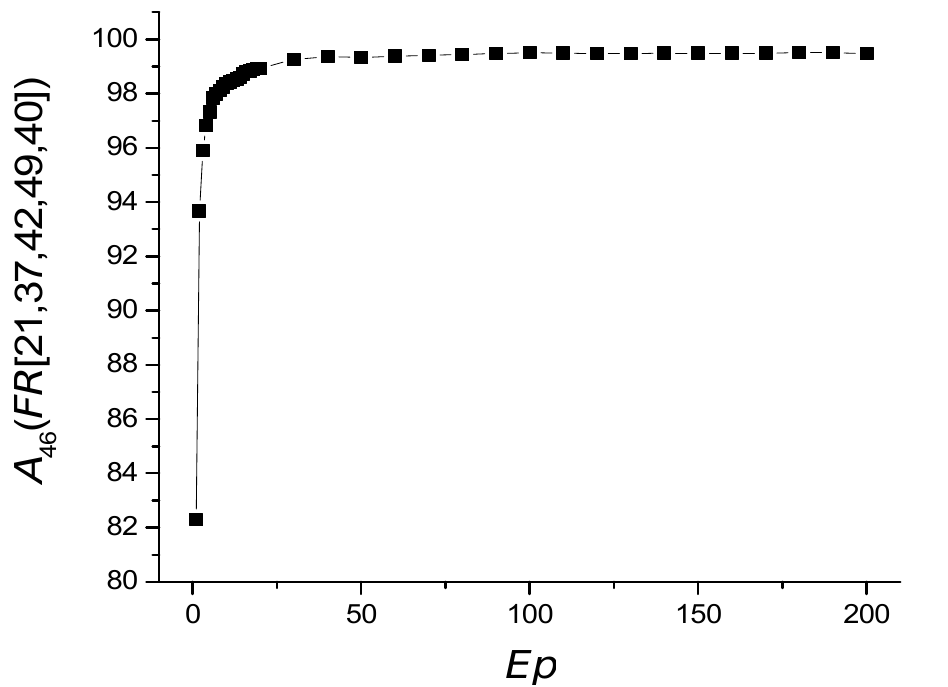
Figure 4. Function of the feature strength dA 51 ( z ) ( a ), dA 46 ( z ) ( b ). The dependence of A ( FR [21,37,40,42,49]) on the number of epochs is shown in 46 Figure 5, and the values of other metrics are shown in Table 5.